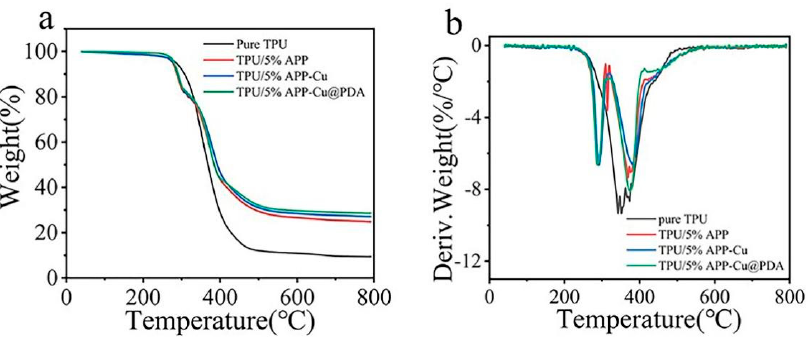
Figure 3. ( a ) SEM images of APP, ( b ) SEM images of APP-Cu@PDA, and mapping images of APP- Cu@PDA.